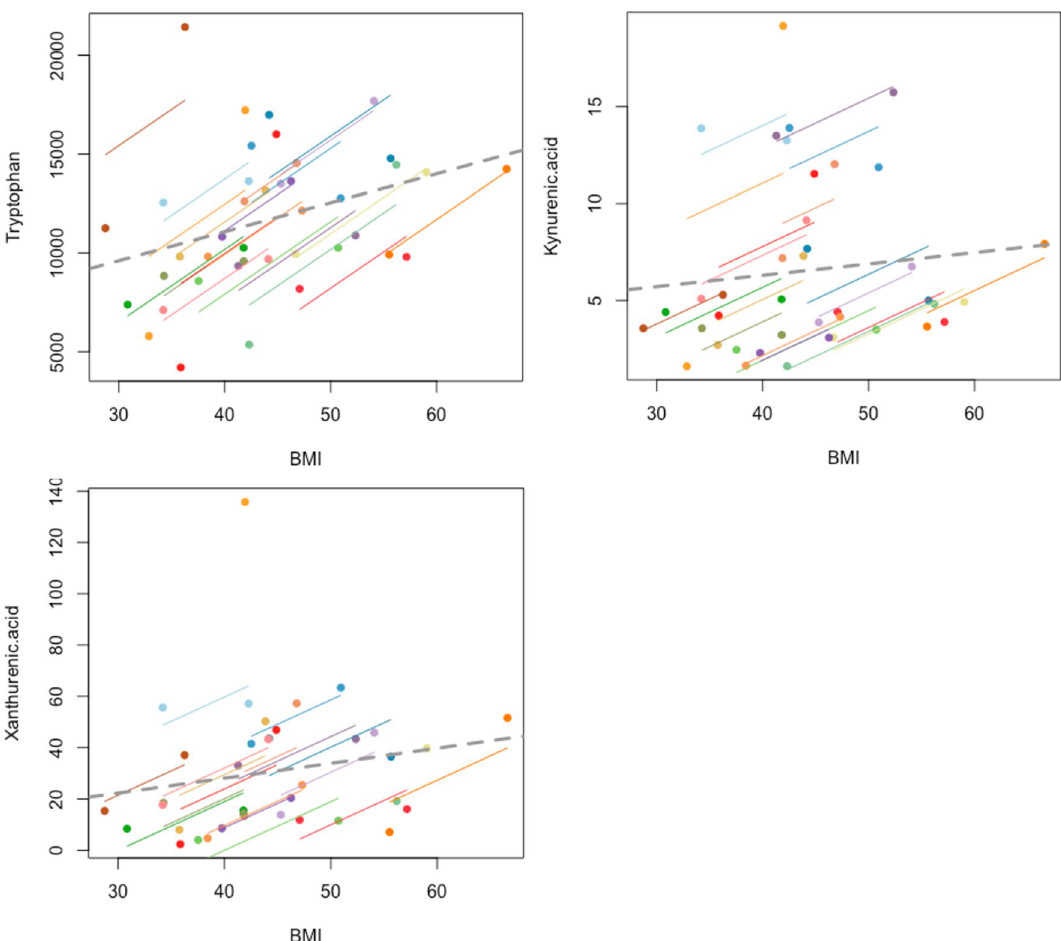
Figure 4. Repeated measure correlation plots of BMI with tryptophan, kynurenic acid and xanthurenic acid levels respectively. Metabolite units (ng/ml), BMI (kg/m 2